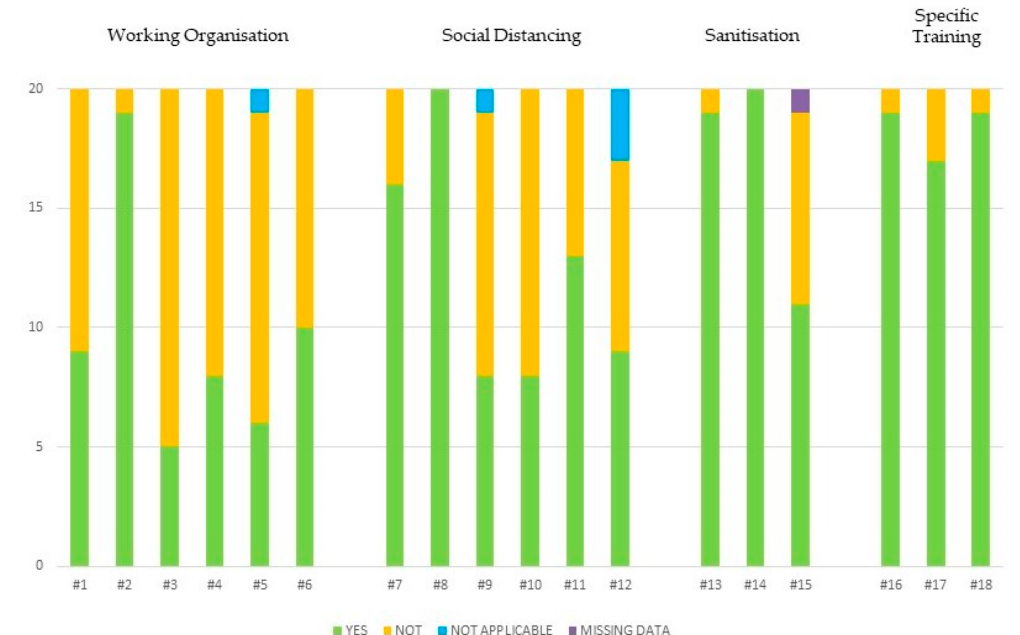
Figure 2. Graphical analysis of the responses’ distribution.